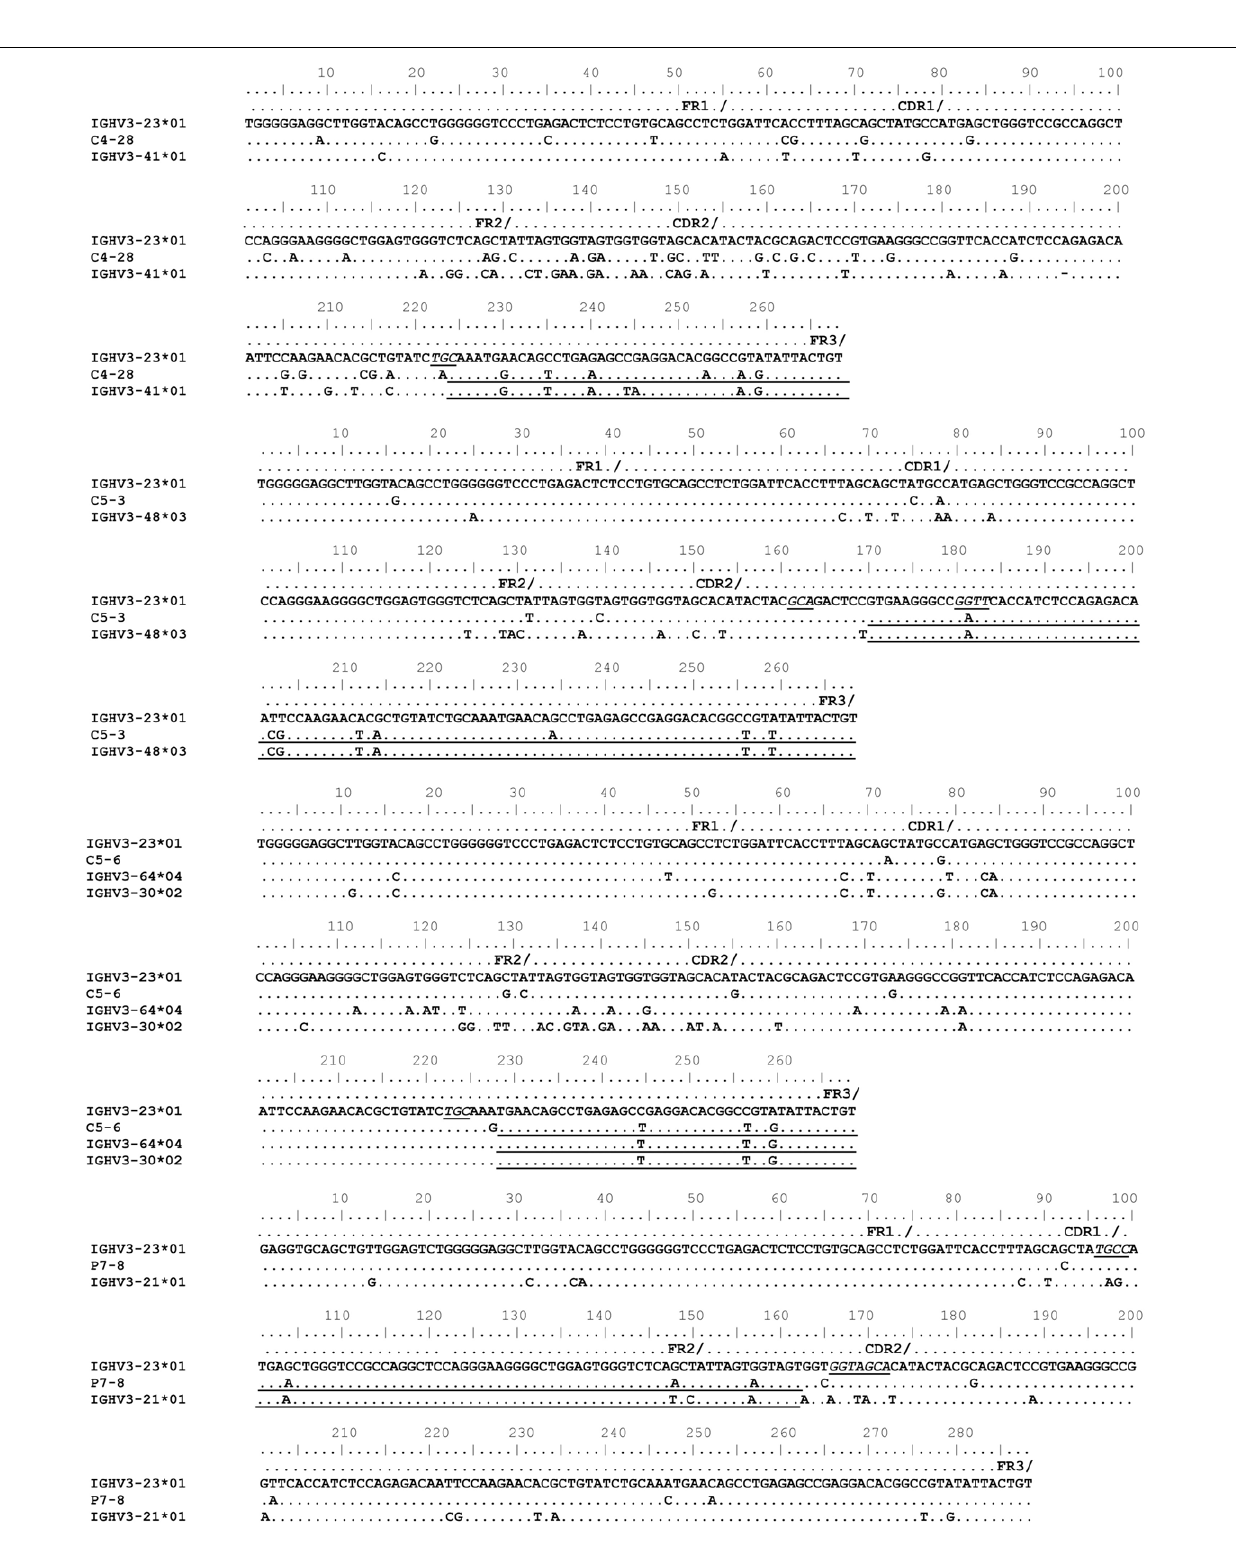
FIGURE 6 | Gene conversion-like events between rearranged IGHV3-23*01 gene sequences and germlineVHsequences superimposed by somatic hypermutation (SHM). Topmost sequence is the germline of rearranged IGHV3-23*01 gene sequences from healthy individuals (C4–28,